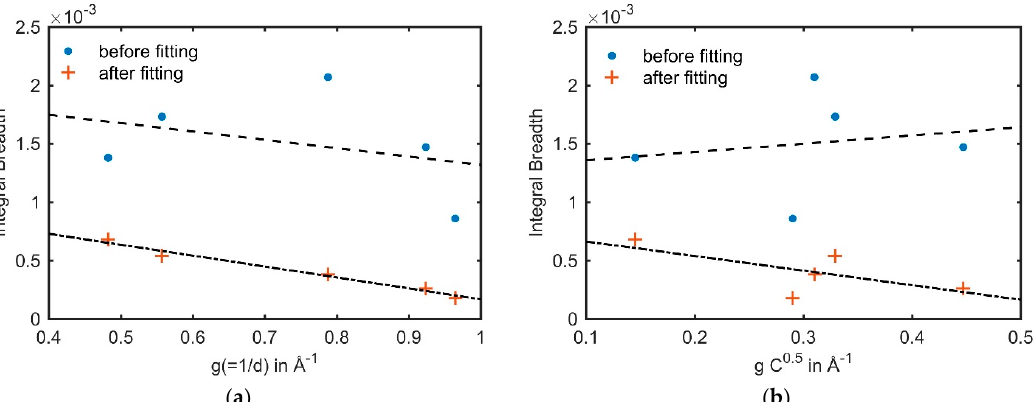
Figure 2. Example of the fitting procedure for grain #29 at 0.09 nominal strain. ( a ) Conventional WH plot and ( b ) modified WH